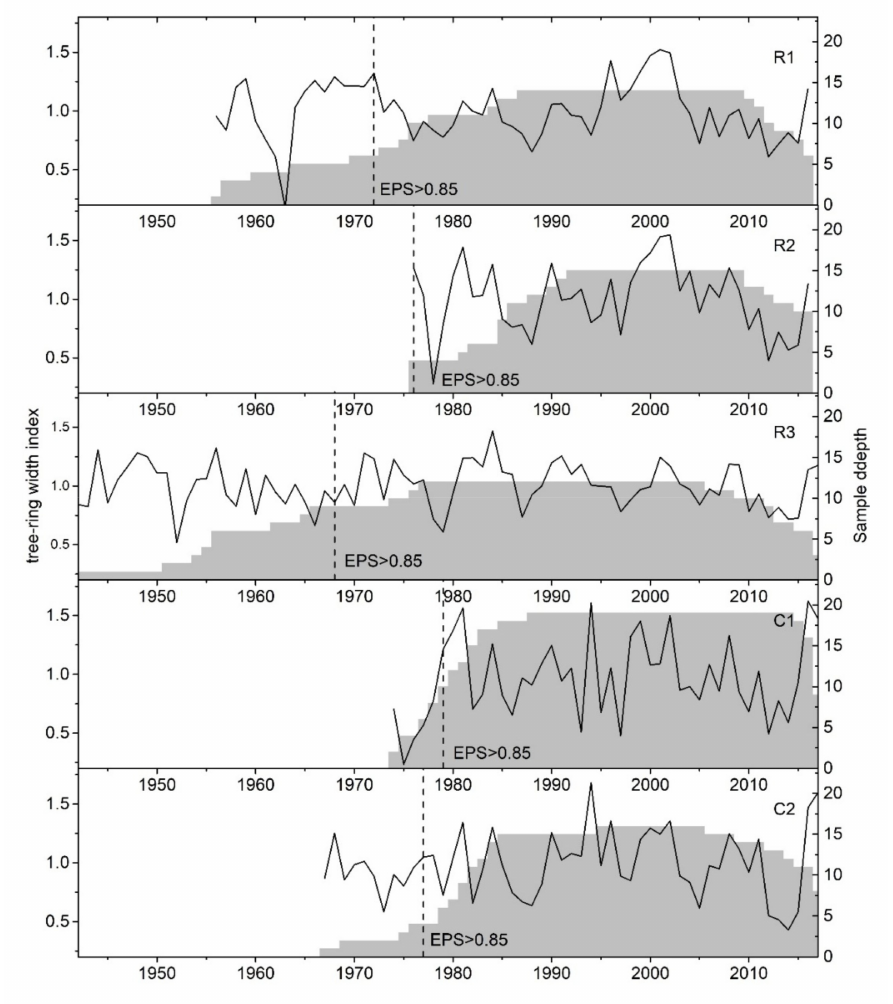
Figure 2. Chronologies of tree ring widths for five sample sites. The curves and grey areas correspond to the tree ring width index and the sample depth, respectively. EPS is express population